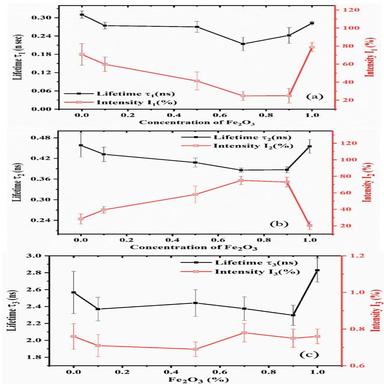
Variation of positron annihilation lifetime and their relative intensities (a) τ1 (ns), I1 (b) τ2 (ns), I2 and (c) τ3 (ns), I3 for In2O3–Fe2O3 NCs as a function of Fe2O3 contents.